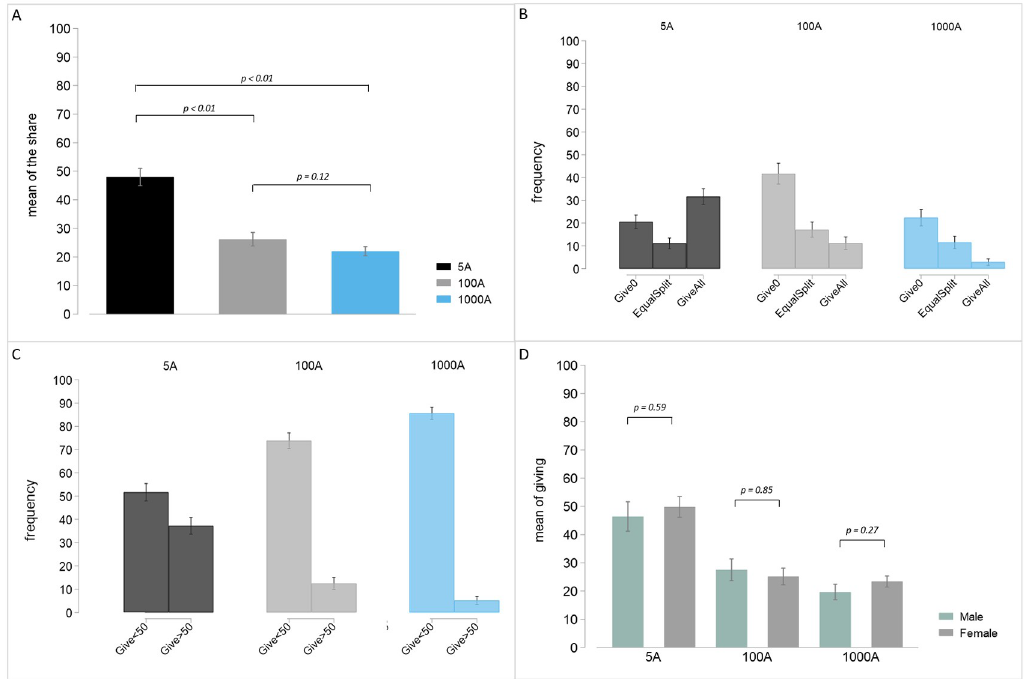
Fig 2. Additional behavioral patterns in the 5 € , 100 € , and 1000 € treatments. A. Average donated share of the pie. B. Shares of particular altruistic types: Give 0 correspond to people giving nothing; EqualSplit correspond to people giving one half of the pie; GiveAll are people who donate all the money. C. Fractions of subjects donating less than 50% ( Give < 50) or more than 50% ( Give > 50). D. Average giving by gender. Grey vertical lines represent standard errors of the mean.